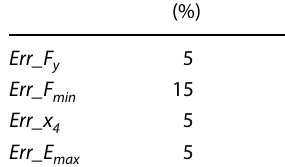
Table 4 4 error ratio predefinitions